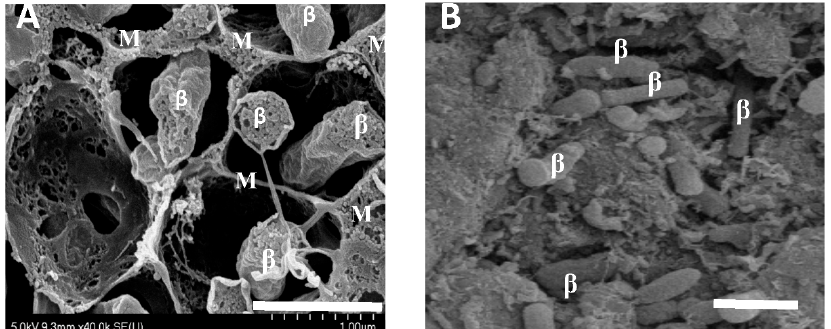
Figure 2. Scanning electron micrographs of soybean nodules 42 and 95 days after planting. ( A ) A soybean nodule at 42 days after planting. Bar represents 1 µm. ( B ) A soybean nodule at 95 days after planting. Bar represents 1 µm. Bacteroids are indicated as “ β ”; membranes and cellular material are indicated by “M”.